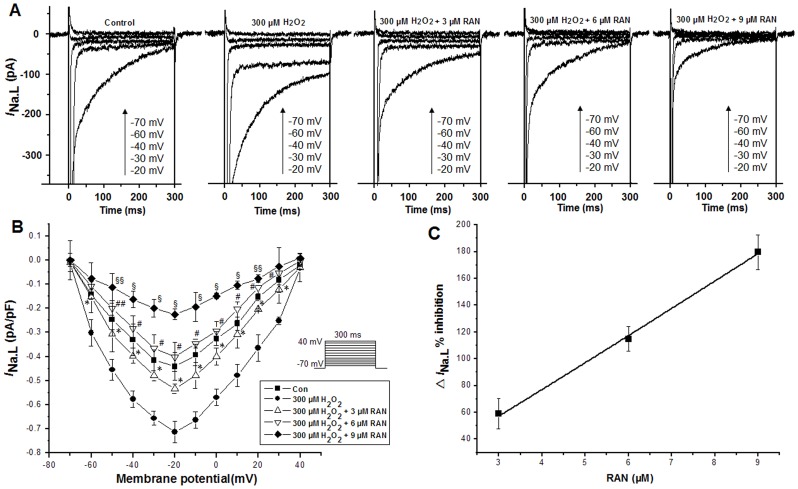
Ranolazine (RAN) inhibited the increase in I
Na.L caused by 300 µM H2O2.
A. 3, 6 and 9 µM ranolazine decreased the amplitudes of the increased I
Na.L induced by 300 µM H2O2 in a concentration dependent manner. B. The I-V relationships of I
Na.L after the sequential application of H2O2 alone, H2O2 plus 3, 6 and 9 µM ranolazine. C. the inhibition amounts of 3, 6 and 9 µM ranolazine on △I
Na.L induced by 300 µM H2O2. Values are expressed as mean ± SD, n = 8 cells/group. *P<0.01 versus H2O2 group; #P<0.01, ##P<0.05 versus 3 µM ranolazine group; §P<0.01, §§P<0.05 versus 6 µM ranolazine group.